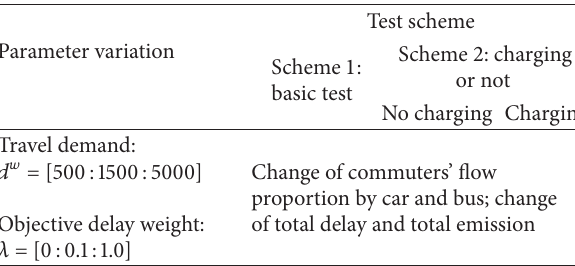
Table 7: Numerical simulation